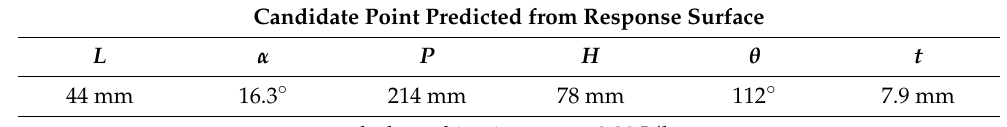
Table 5. The result obtained from response surface.